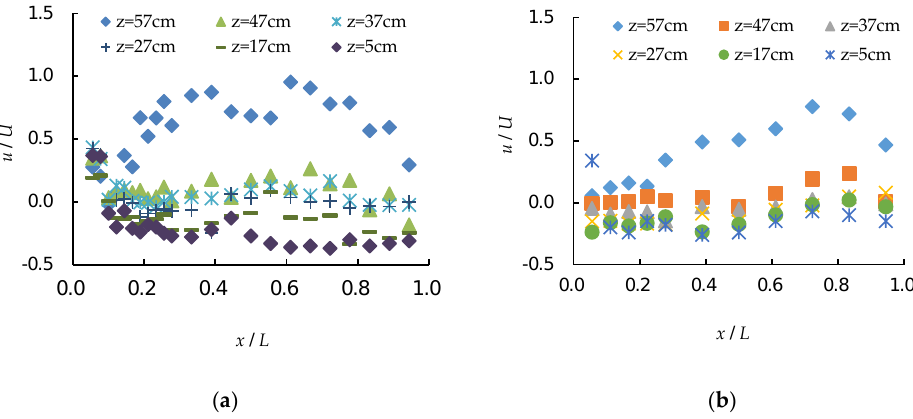
Figure4. Variationinlongitudinalvelocityalongtheflowdirection. ( a ) Q 1 = 20.79L / s; ( b ) Q 2 = 30.04 L / s. Figure 4. Variation in longitudinal velocity along the flow direction . ( a ) Q 1 = 20.79 L/s; ( b ) Q 2 = 30.04 L/s.